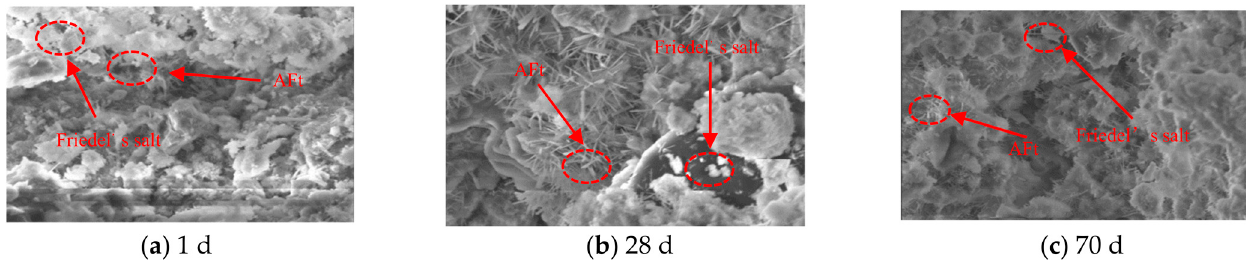
Figure 5. SEM images of T3 specimen at 1 d, 28 d, and 70 d.